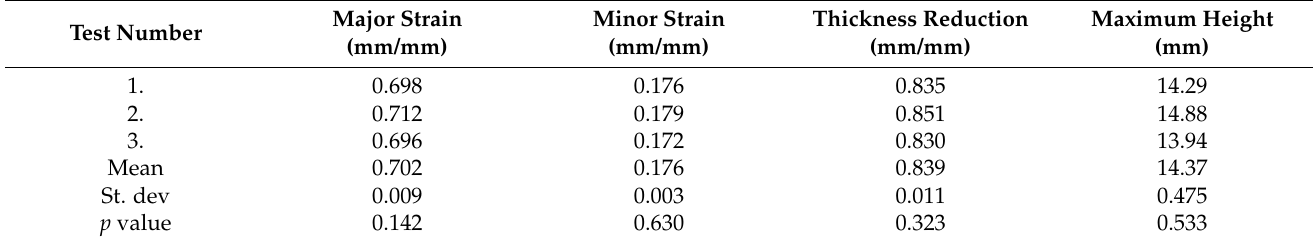
Table 11. Results of the uniaxial tool path test for unwelded sheets.